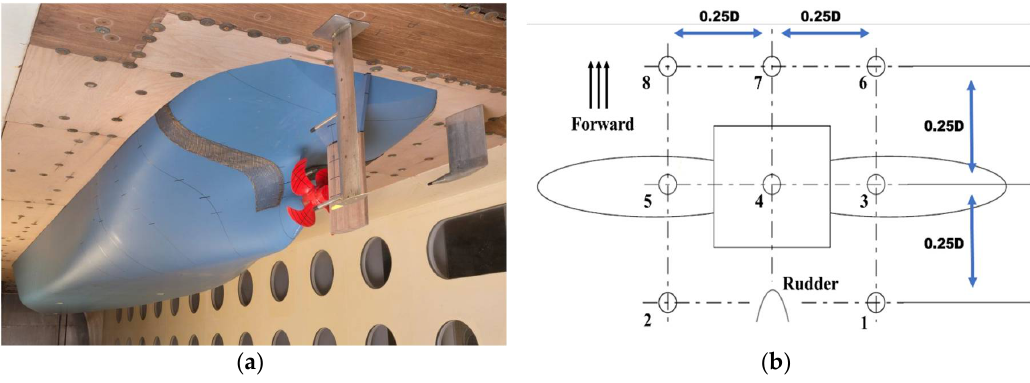
Figure 4. ( a ) Photo of the model test facility and ( b ) pressure transducer arrangement and numbering.